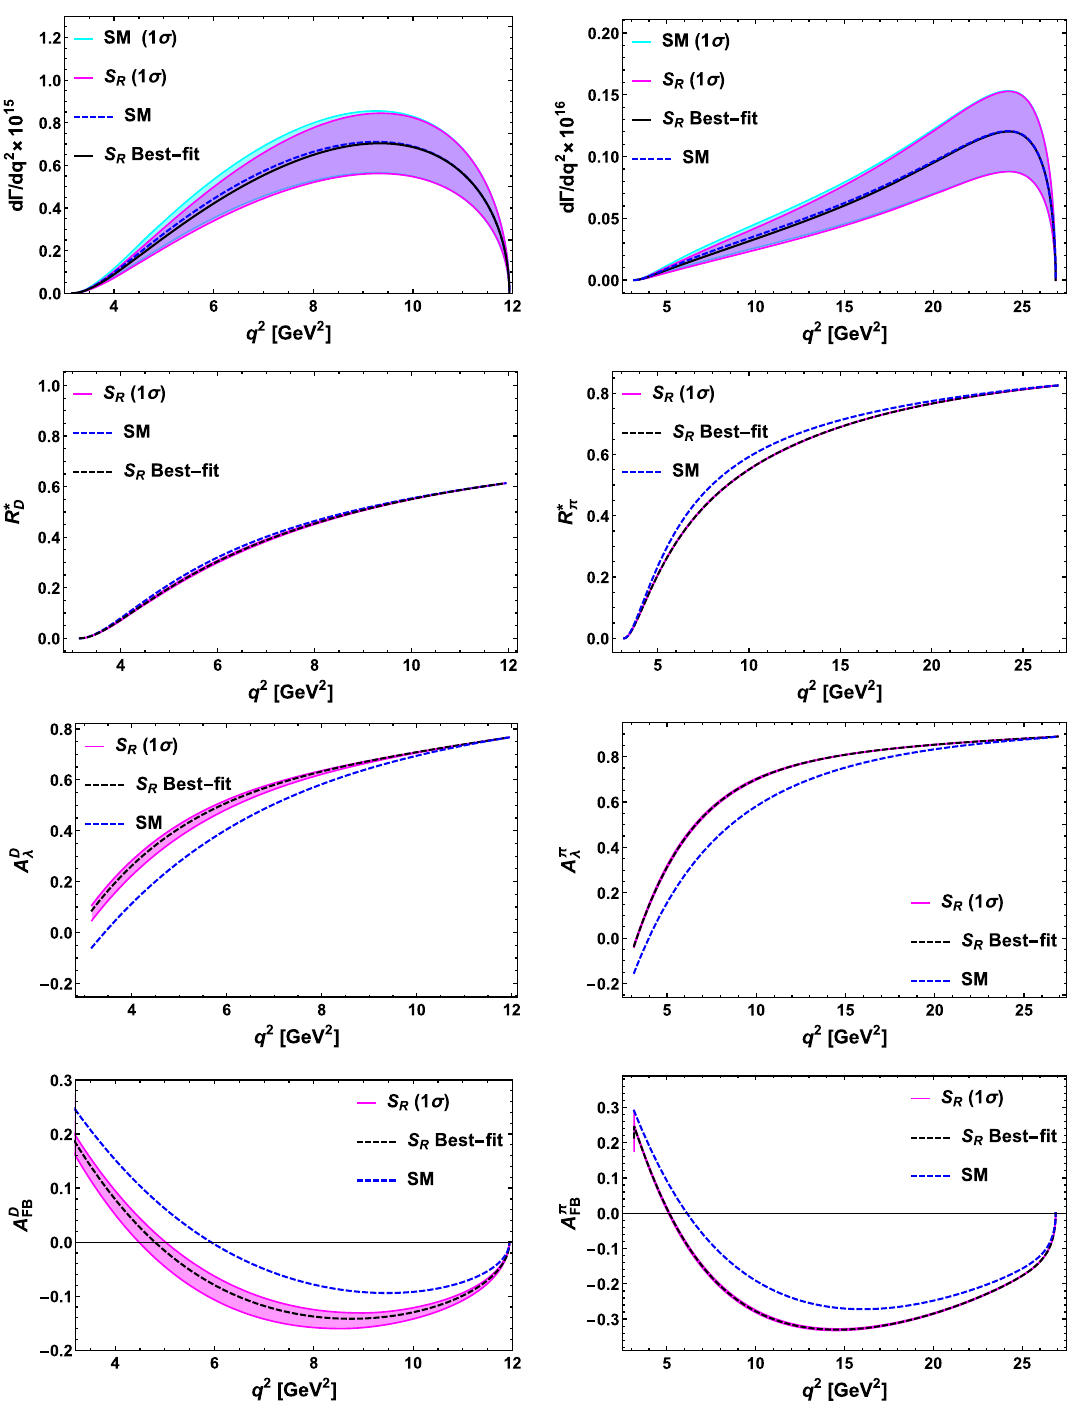
Fig. 6 The q 2 variation of differential decay rate, LNU observable, lepton spin asymmetry and forward–backward asymmetry of ¯ B ∗ → π + τ ¯ ν τ (right panel) in presence of D + τ − ¯ ν τ (left panel) and ¯ B ∗ d